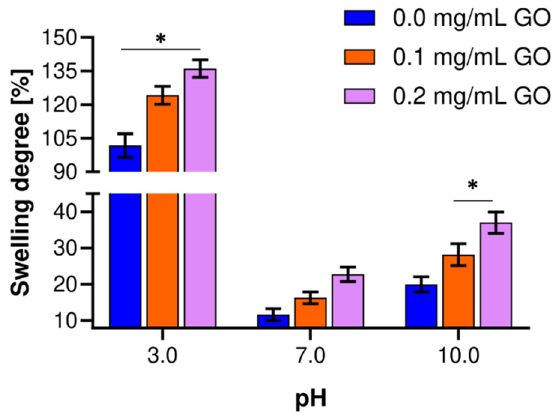
Figure 4. Swelling behavior of hydrogels prepared with varying levels of GO and different pH values. The experiments were conducted in an aqueous solution and 30 °C. *, p <0.05.